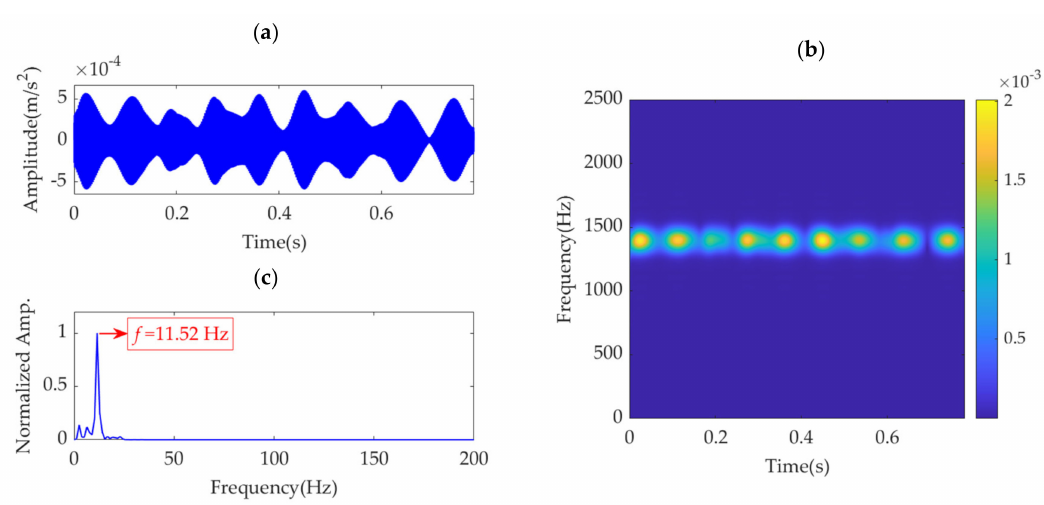
Figure 22. Desired mode obtained by VME with the optimal parameters: ( a ) time–domain waveform, ( b ) STFT spectrum, and ( c ) SES.